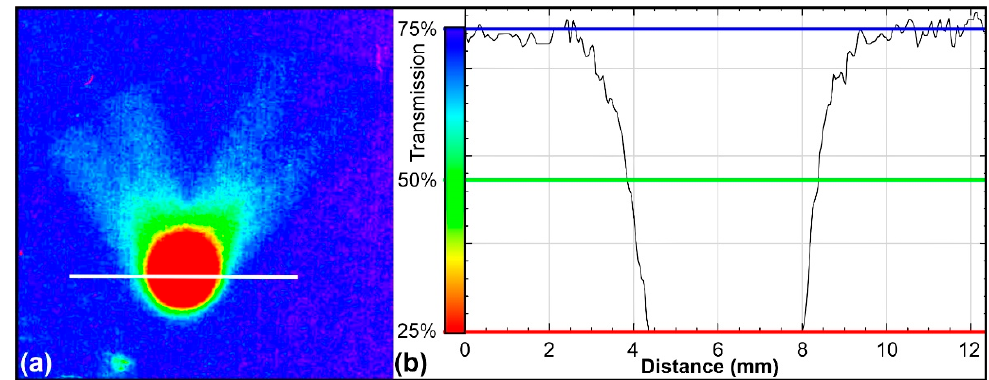
Figure 7. ( a ) Typical time-integrated pinhole radiograph. ( b ) Lineout along the diameter of the cross-point area.